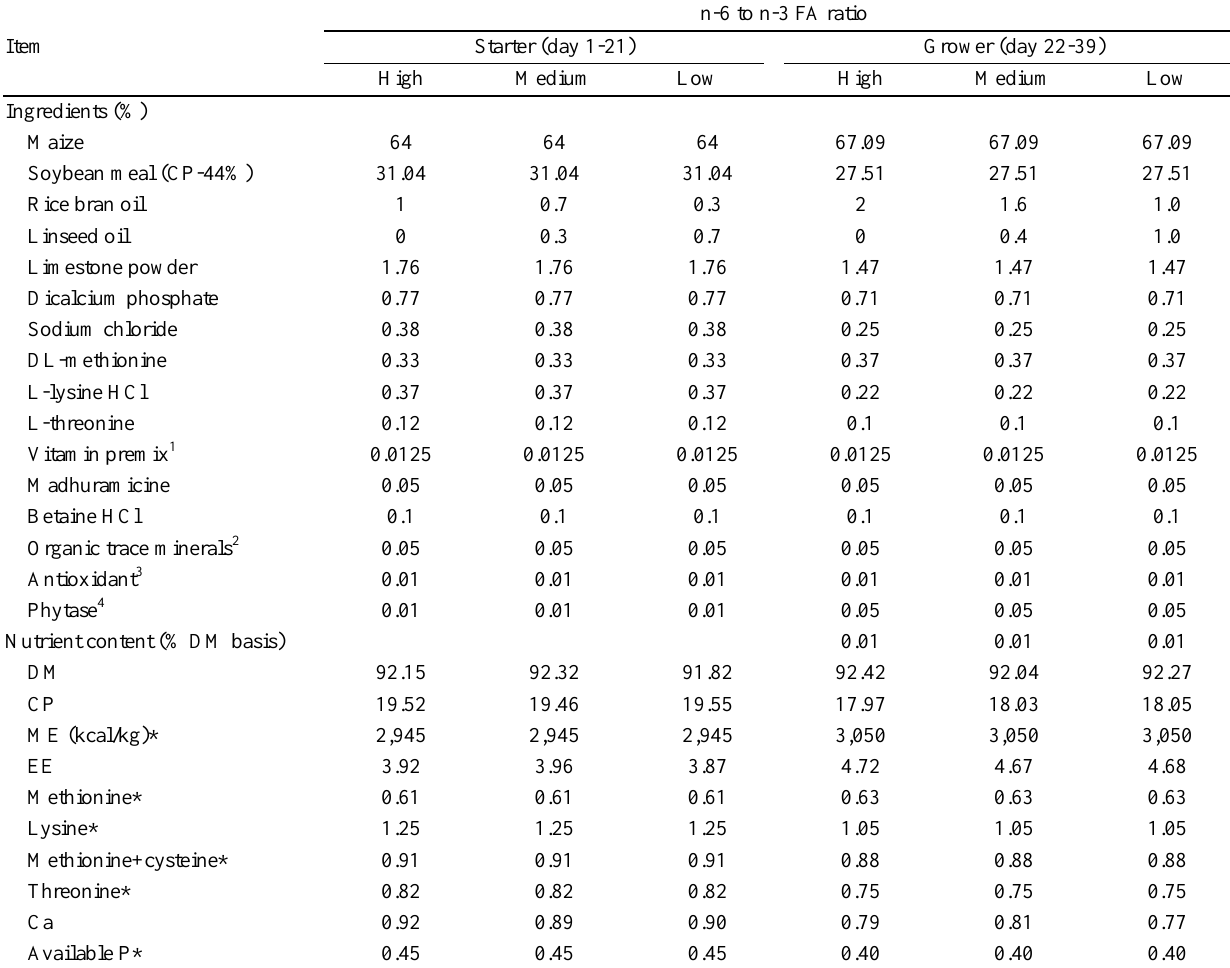
Table 1. Ingredient composition and nutrient content of experimental diet